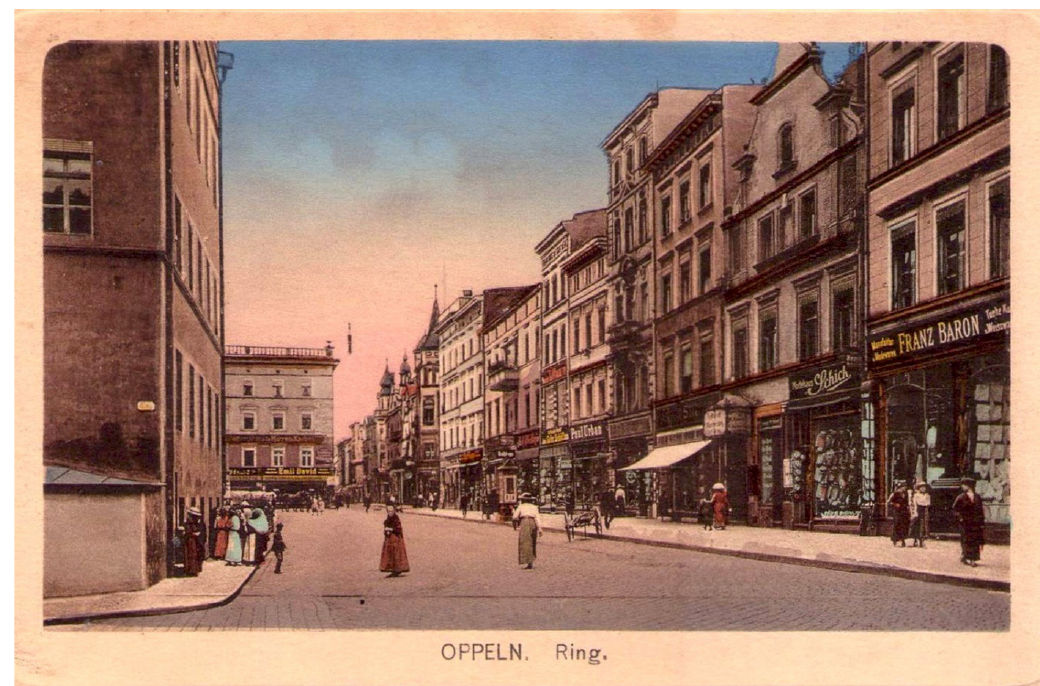
Figure 3. Eastern frontage of the Market Square in Opole before 1945. Source: Wikimedia Commons (2021).